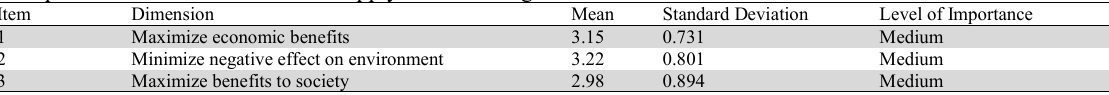
Descriptive statistics for Sustainable Supply Chain Strategies